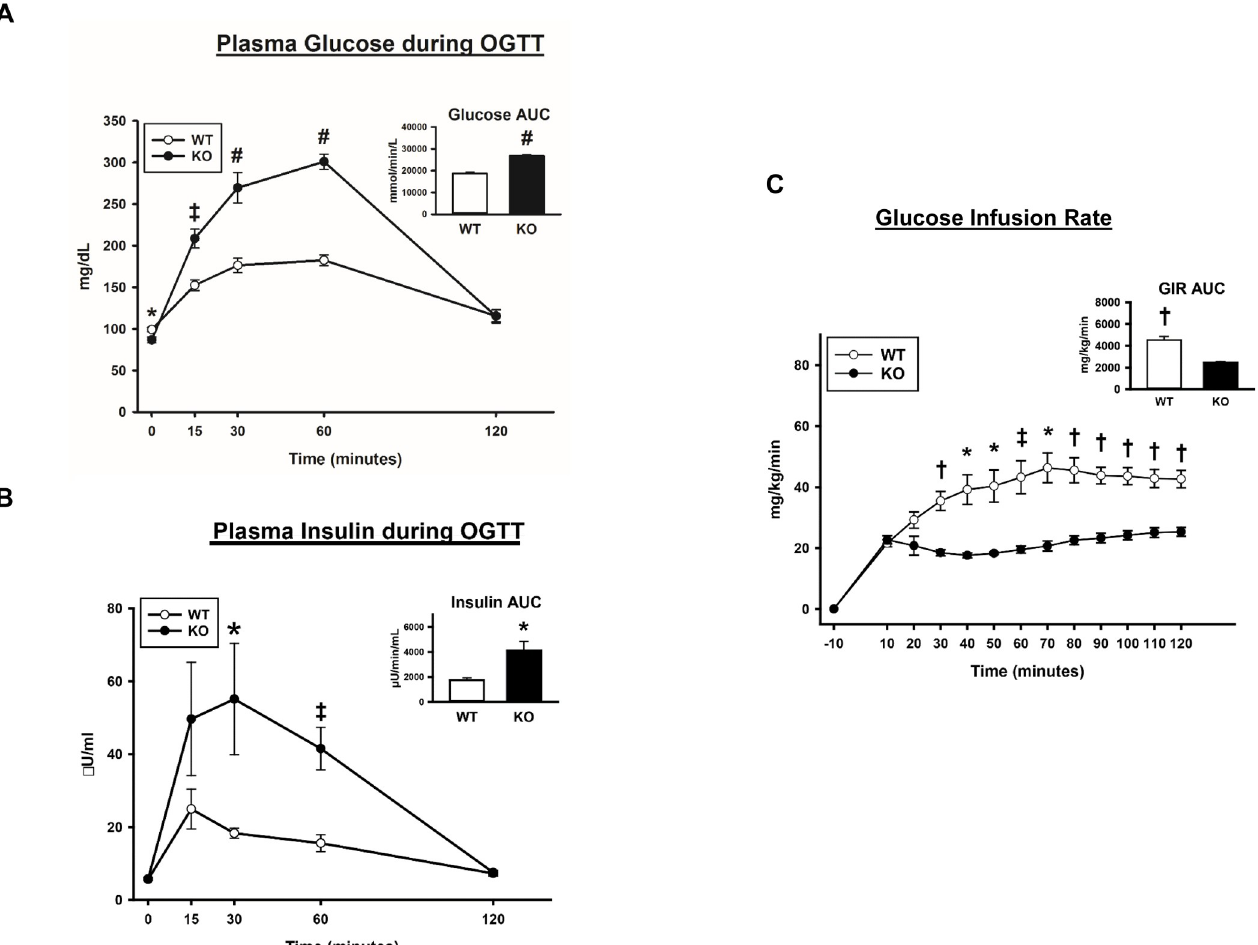
Fig 2. Oral glucose tolerance test = OGTT. Glucose infusion rate = GIR during the HEC in wildtype (WT; white bars and white circles) and AS160-KO (K O; black bars and black circles) rats. Area under the curve (AUC; inset) for (A) glucose and (B) insulin. Data were analyzed by Student’s t-test. � P < 0.05, ‡ P < 0.005 and # P < 0.001 for WT versus KO rats. Means ± SEM for 6 rats of each genotype. (C) GIR for rats during the HEC. AUC for GIR (inset). Data were analyzed by Student’s t-test. � P < 0.05, † P < 0.001 and ‡ P < 0.005 for WT versus KO. Means ± SEM for 4 rats of each genotype. significant differences between AS160-KO compared to WT rats was found for blood glucose values, plasma insulin values, glucose turnover rate (GTR) or hepatic glucose production (HGP; Table 4). Blood glucose during the HEC was ~18.6% lower (P < 0.05) in AS160-KO compared to WT rats. Plasma insulin levels during the HEC did not differ for AS160-KO ver- sus WT rats (Table 4). HGP and insulin suppression of HGP were not significantly different for AS160-KO compared to WT animals. The GIR (glucose infusion rate) AUC during the HEC was much lower for AS160-KO compared to WT rats (47.5%; P < 0.001; Fig 2C). GIR was significantly lower at minutes 30, 40, 50, 60, 70, 80, 90, 100, 110, 120 (P < 0.05 to 0.001). GTR was much less in AS160-KO compared to WT animals (65%; P < 0.001). There were no differ- ences between genotypes for plasma non-esterified fatty acid (NEFA) at baseline or during the HEC (WT versus AS160-KO: -10 minutes, 0.489 ± 0.014 versus 0.550 ± 0.048; 80 minutes, 0.141 ± 0.002 versus 0.152 ± 0.005; 90 minutes, 0.131 ± 0.006 versus 0.155 ± 0.009; 120 minutes, 0.141 ± 0.011 versus 0.16 ± 0.011).